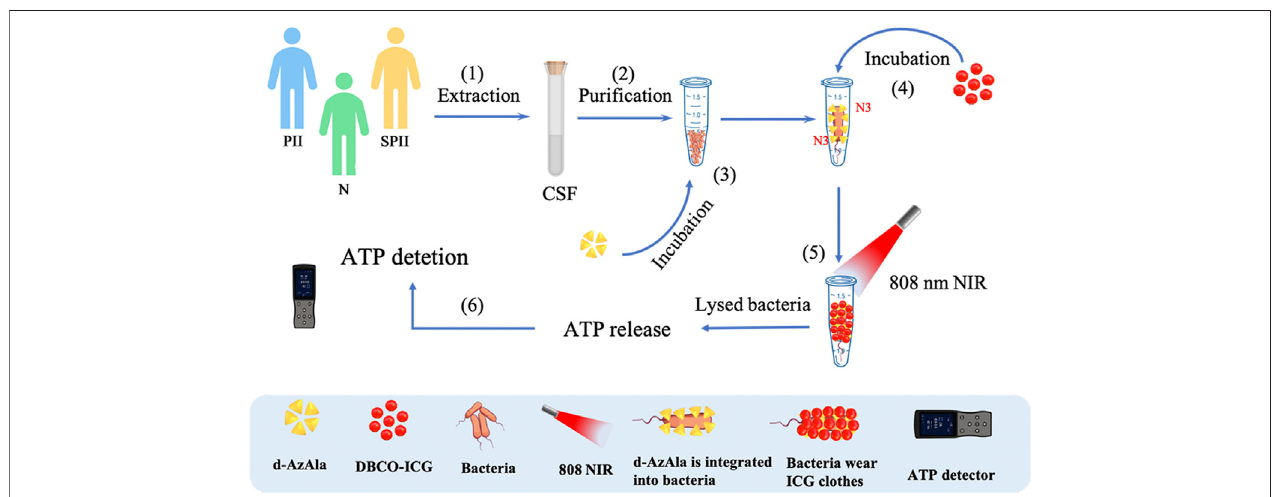
FIGURE 1 | Detection of bacteria using sulfo-DBCO-ICG reacted with d-AzAla modi fi ed bacteria by copper-free click chemistry-mediated photothermal lysis and measurement of ATP bioluminescence. (1) Extraction of CSF from patients (postoperative with intracranial infection (PII), suspected postoperative with intracranial infection (SPII), normal (N)). (2) Puri fi cation of CSF to remove red blood cells. (3) Feeding of d-AzAla to bacteria and the cell walls of bacteria to carry N3 groups. (4) The sulfo-DBCO-ICG was then incubated with N 3 -modi fi ed bacteria, and the sulfo-DBCO-ICG reacted with the modi fi ed bacteria through click chemistry, formed